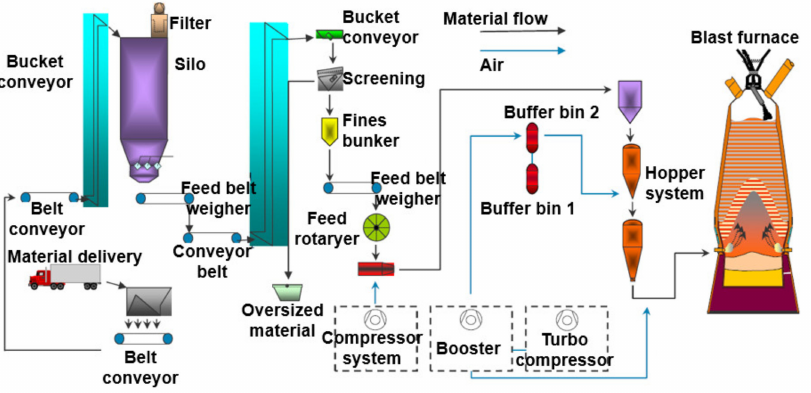
Figure 14. Flowchart of a waste plastic injection plant at a blast furnace